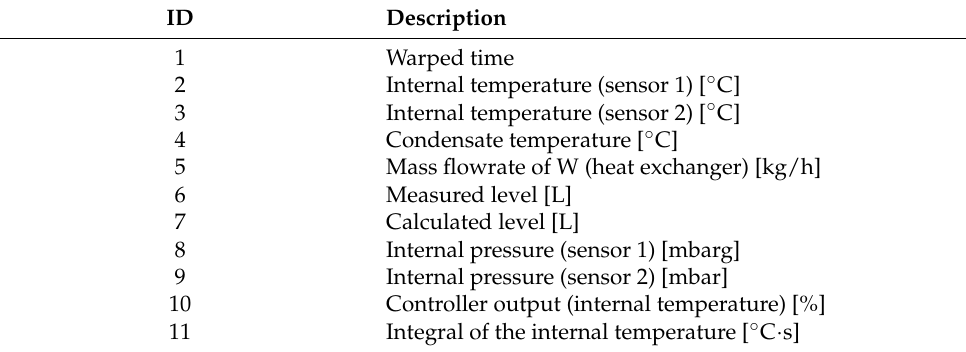
Table A4. List of the process variables analyzed for unit